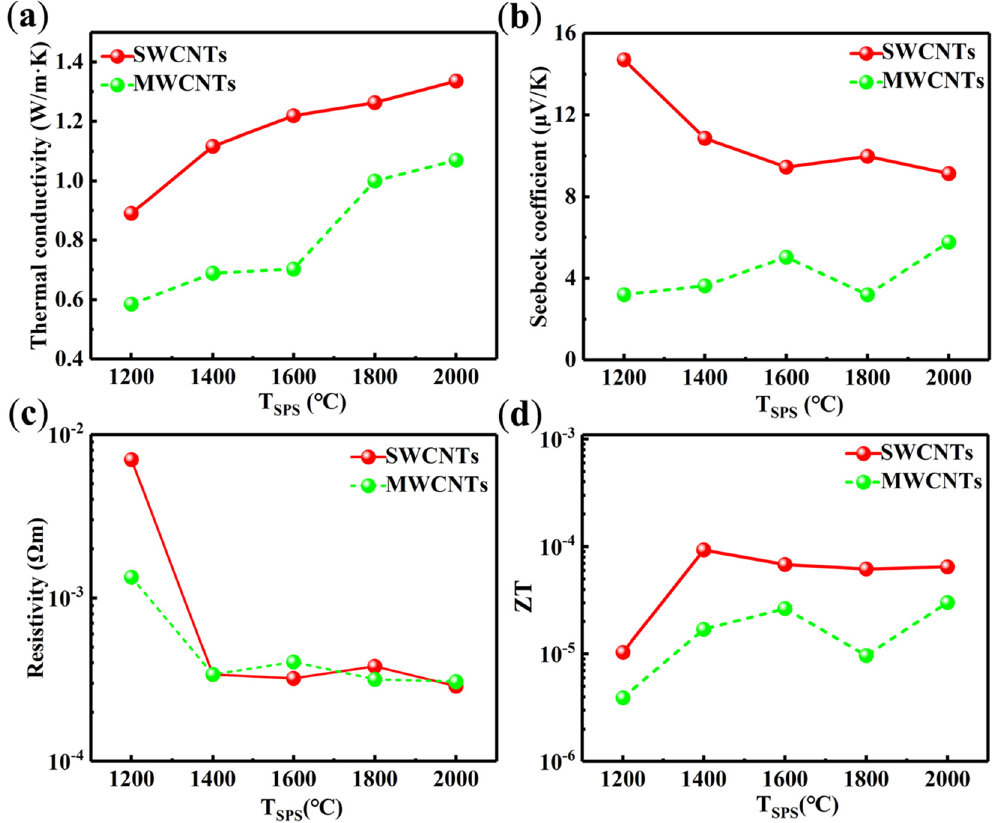
Figure 4: SPS temperature dependence of ( a ) thermal conductivity; ( b ) Seebeck coe ffi cient; ( c ) resistivity; ( d ) ZT ; for single - wall and multi - walled CNT